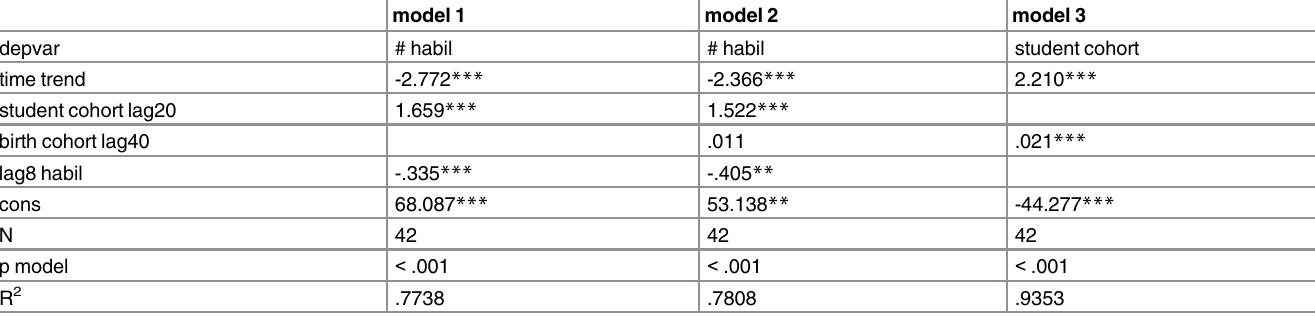
Table 2. Adding Time Trend and Student